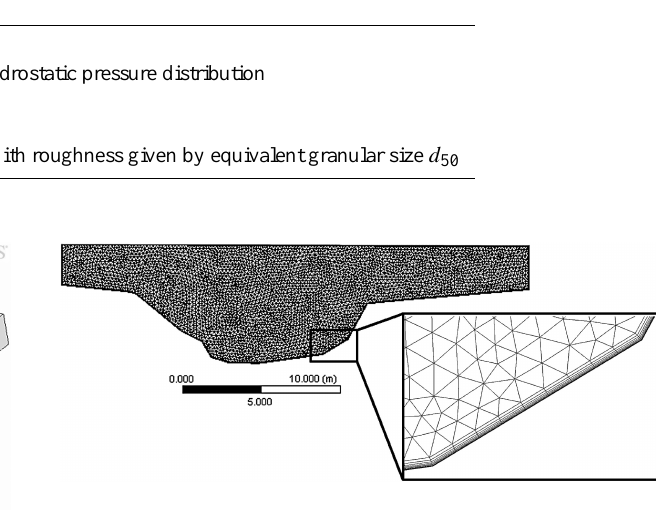
Figure 12. A mesh section along the inlet surface.